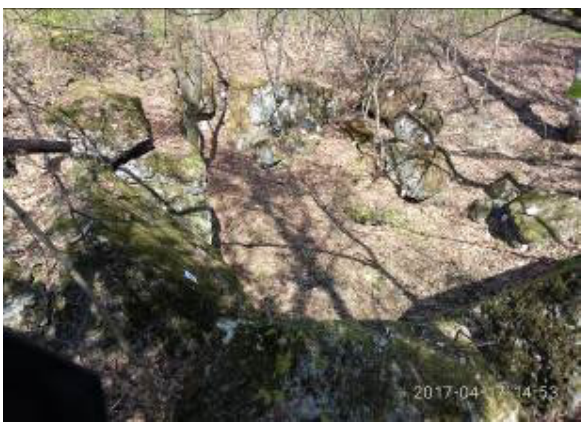
The third object is artillery observation post № 453 with armored cover. It is a one-storey object.